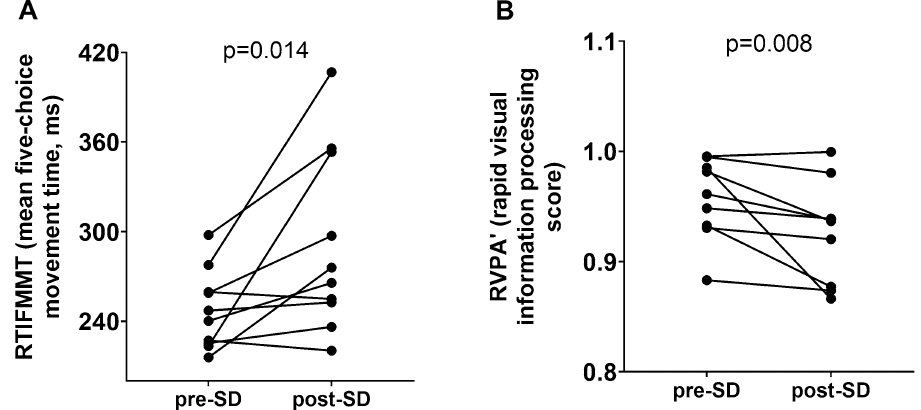
Figure 3. Sleep deprivation impairs cognitive performance. Cognitive performance was evaluated before and after 24 h of sleep deprivation in 10 healthy young (27.6 ± 3.7 years of age) male individuals using a CANTAB battery of tests. Reaction time was measured with the RTI test, and we observed a significant increase in reaction time after sleep deprivation (panel A). Sustained attention was assessed with the rapid visual information processing test (RVP), and we found a significant decrease in performance in this cognitive domain (panel B). Wilcoxon signed-rank test was used for comparisons. p < 0.05 was considered significant. RTIFMMT: Reaction time mean five choice movement time. RVPA: Rapid Visual Processing A’ (A prime) a signal detection measure of the subject’s sensitivity to the target sequence of three numbers, a metric of how good the subject was at detecting targets. Maximal value is 1, being the highest score for the best performance.